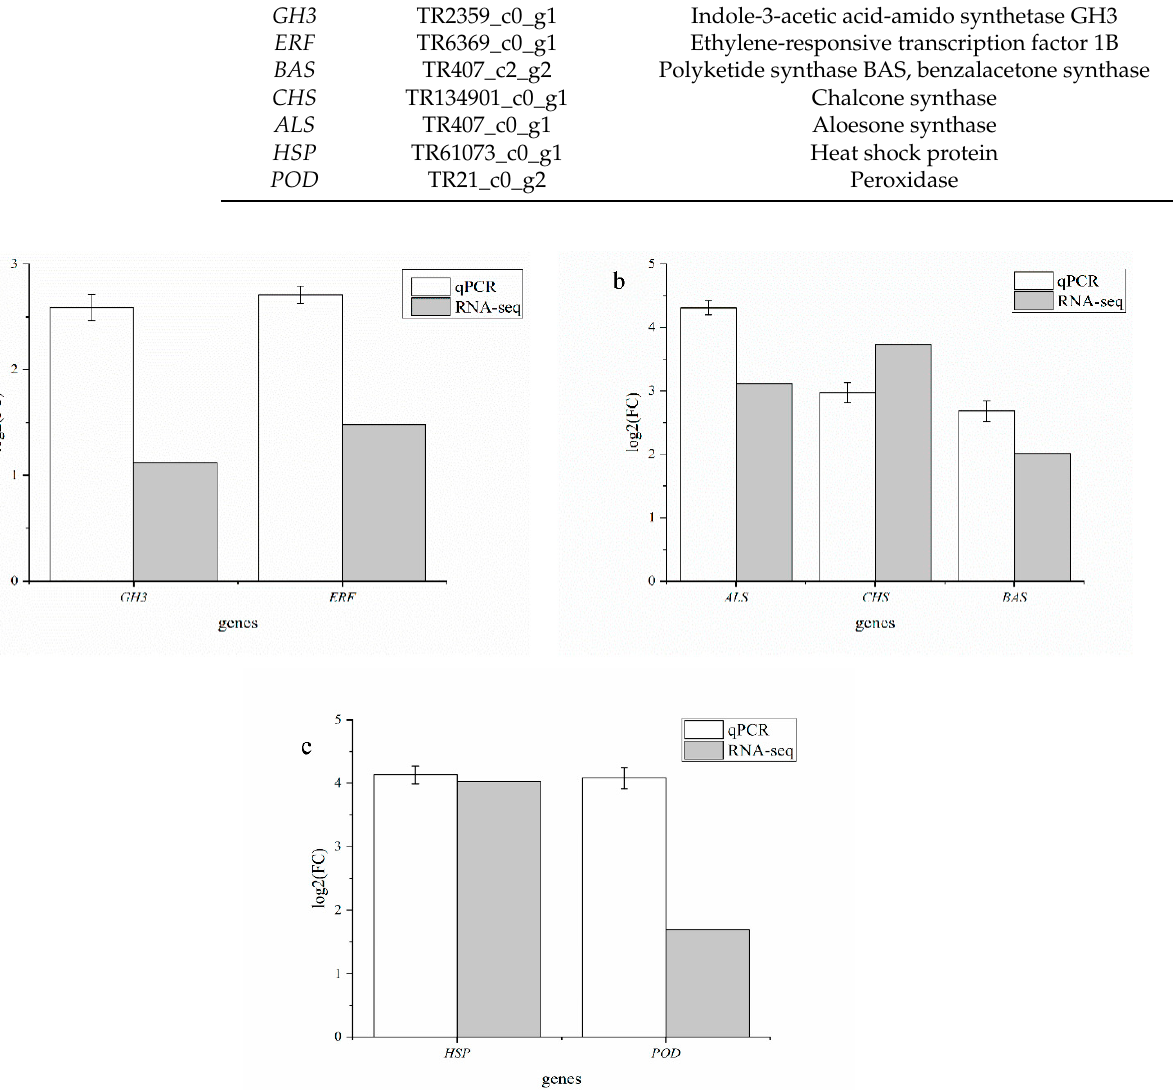
Figure 8. qRT-PCR assay of genes in Rheum palmatum. qRT-PCR verified the accuracy of the tran- scriptome data. ( a ) qRT-PCR results of genes related to plant hormone transduction in R. palmatum . ( b ) qRT-PCR results of genes related to biosynthesis of secondary metabolites in R. palmatum. ( c ) qRT-PCR results of genes related to phenylpropanoid biosynthesis and plant–pathogen interaction in R. palmatum . Error bars indicate the SD from the mean.